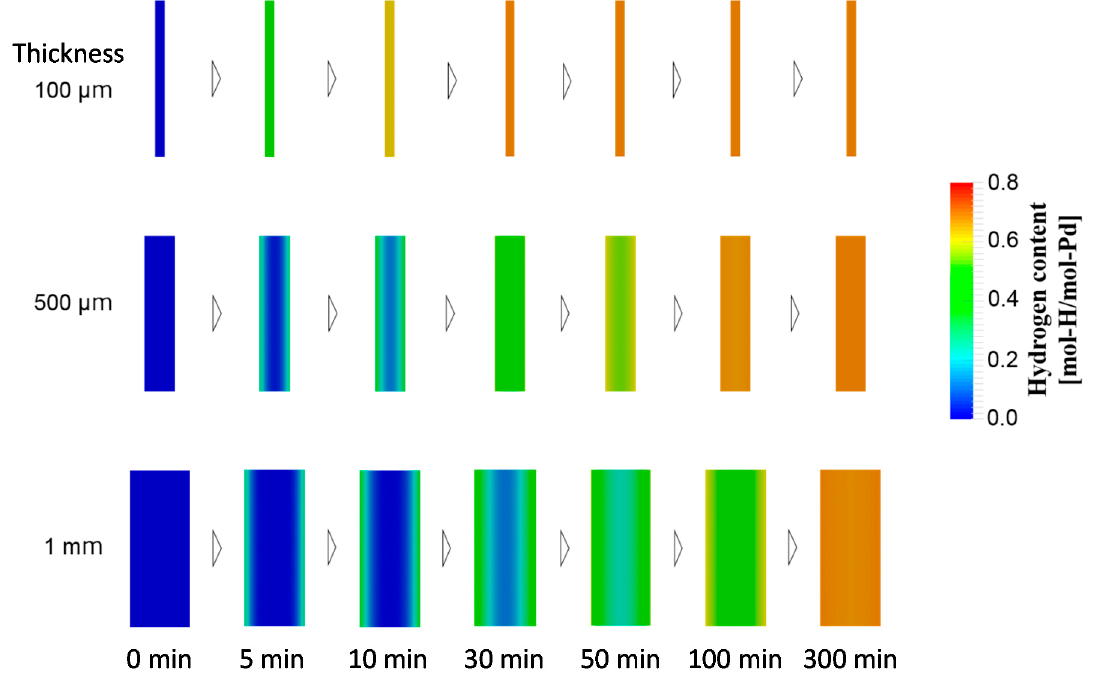
Figure 6. Spatial hydrogen concentration profiles in Pd plates at 5, 10, 30, 50, 100, and 300 min after the beginning of hydrogen absorption process for Pd plates of different thicknesses.